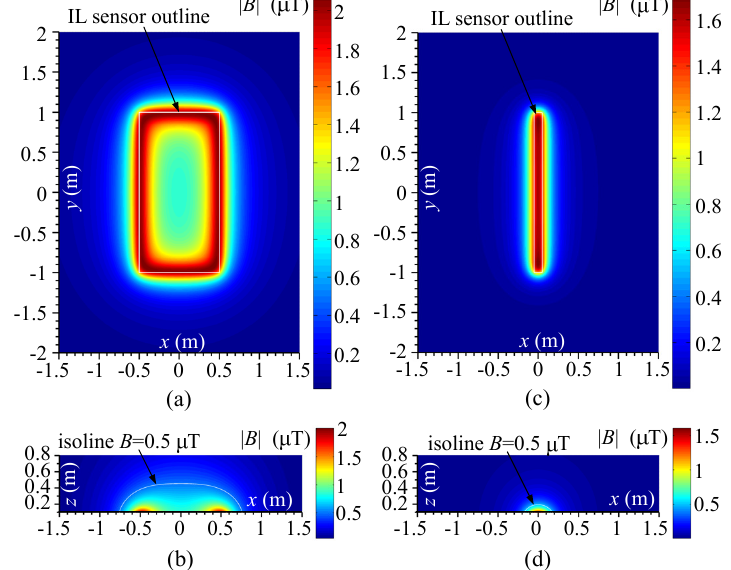
Figure 3. Magnetic field module distribution, | B | (µT), of the standard-loop: ( a ) 10 cm above the plane of the IL wires and ( b ) in vertical cross section. The slim-loop ( c ) 10 cm above the plane of the IL wires and ( d ) in vertical cross